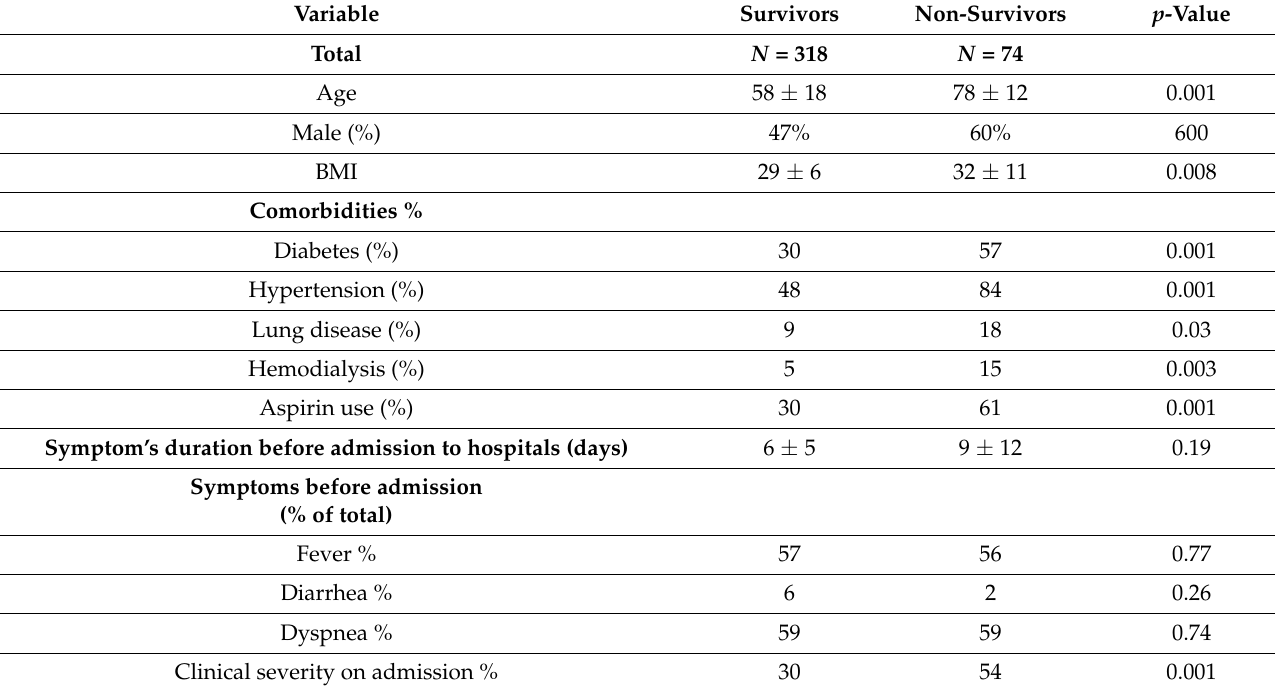
Table 1. Clinical characteristics of the surviving and non-surviving patients with COVID-19 infection. NS: not significant ( p value < 0.05).